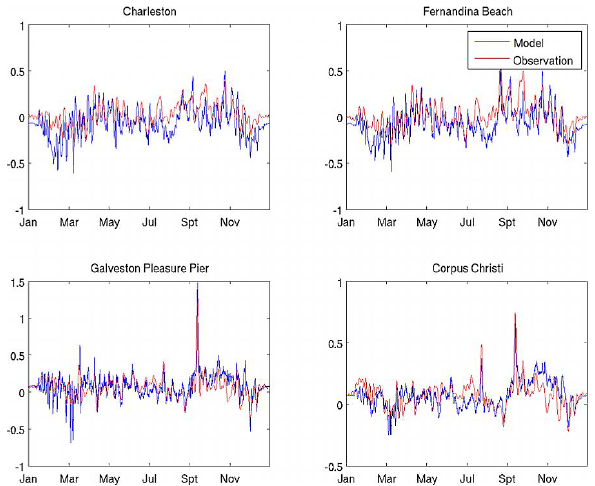
Fig. 3. Comparisons between observed and simulated sea-level time series at four tidal stations in 2008.